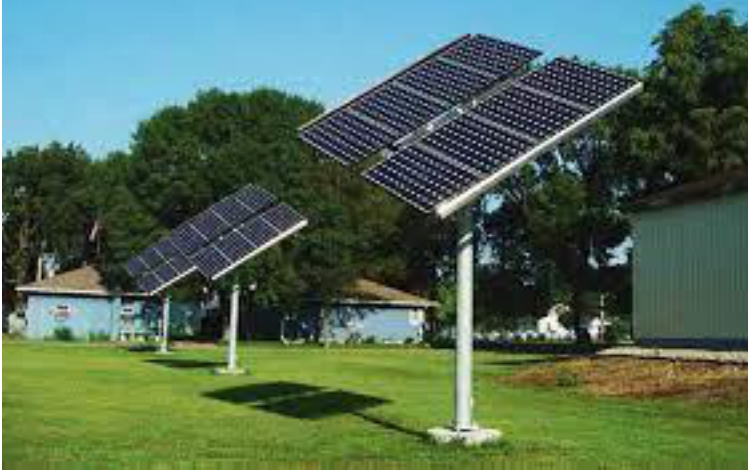
Figure 2. Pole installed solar modules